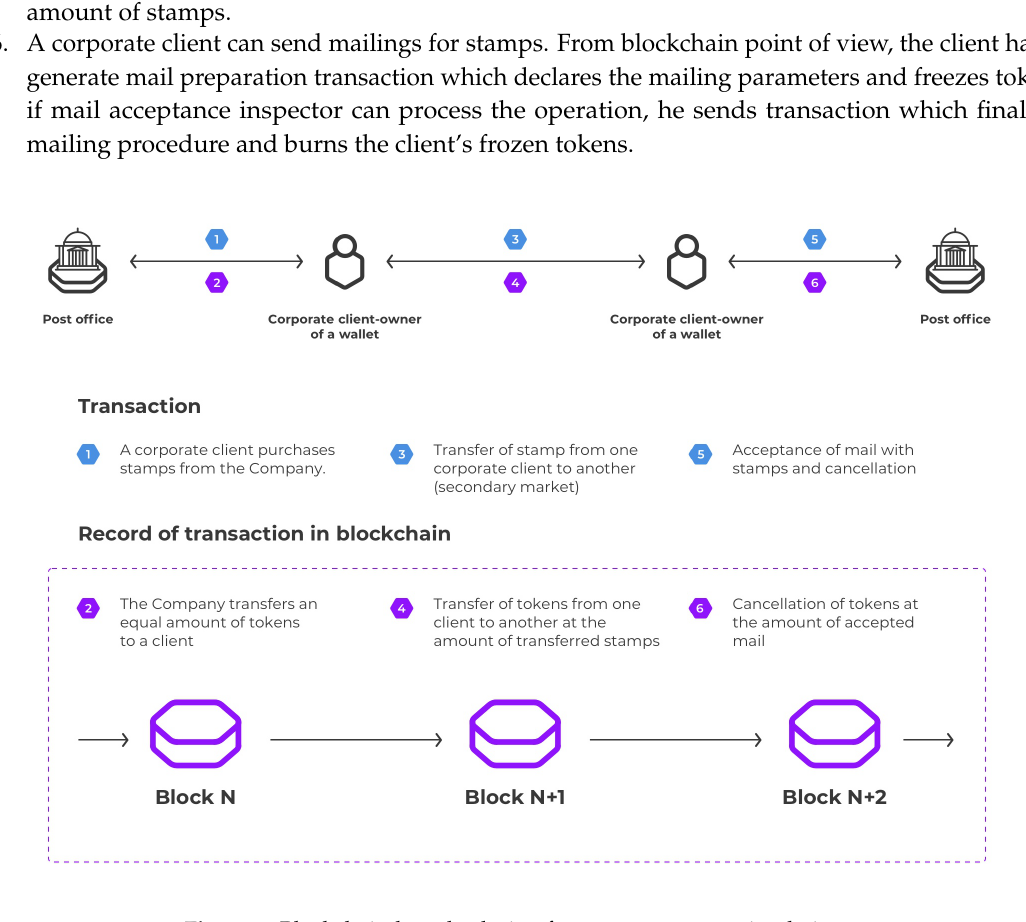
Figure 3. Blockchain-based solution for postage stamps